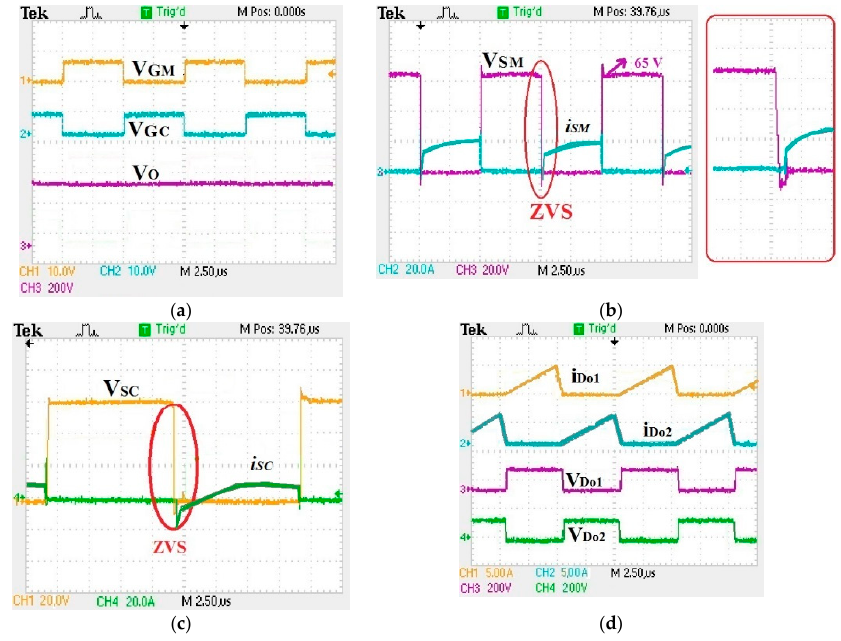
Figure 13. Experimental results for half load power when V in = 30 V, D = 0. 5, and P out = 500 W. ( a ) Gate-source voltage of switches S M and S C , and output voltage V o ; ( b ) gate-source and drain-source voltage of switch S M ; ( c ) gate-source and drain-source voltage of switch S C ; and ( d ) the voltage and current of output diodes D o1 and D o2 .